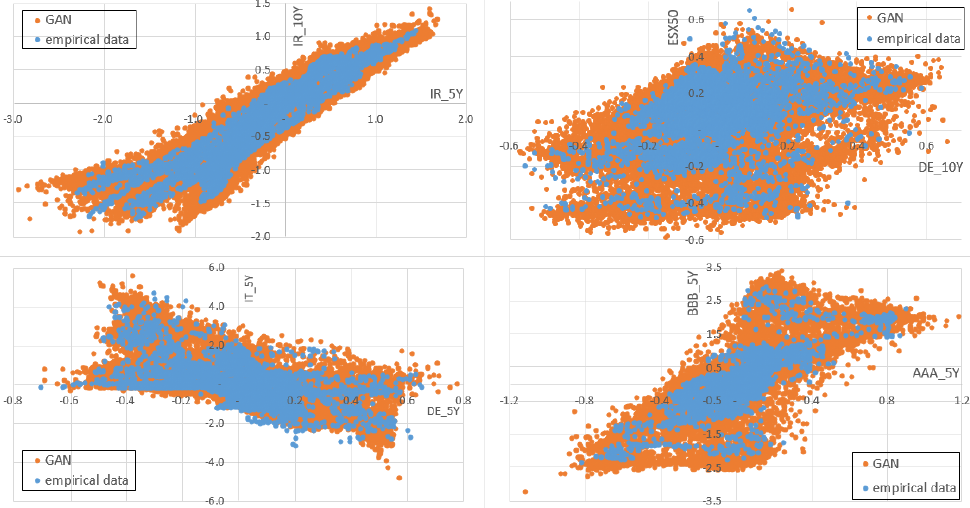
Figure 4. Scatterplots of four different risk factor pairs: empirical vs. generated data by a GAN.